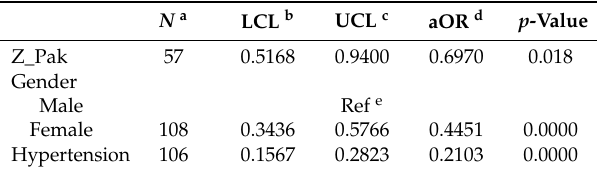
Table 5. Association of dietary supplements, antibiotics, and comorbidities for schizophrenia. N